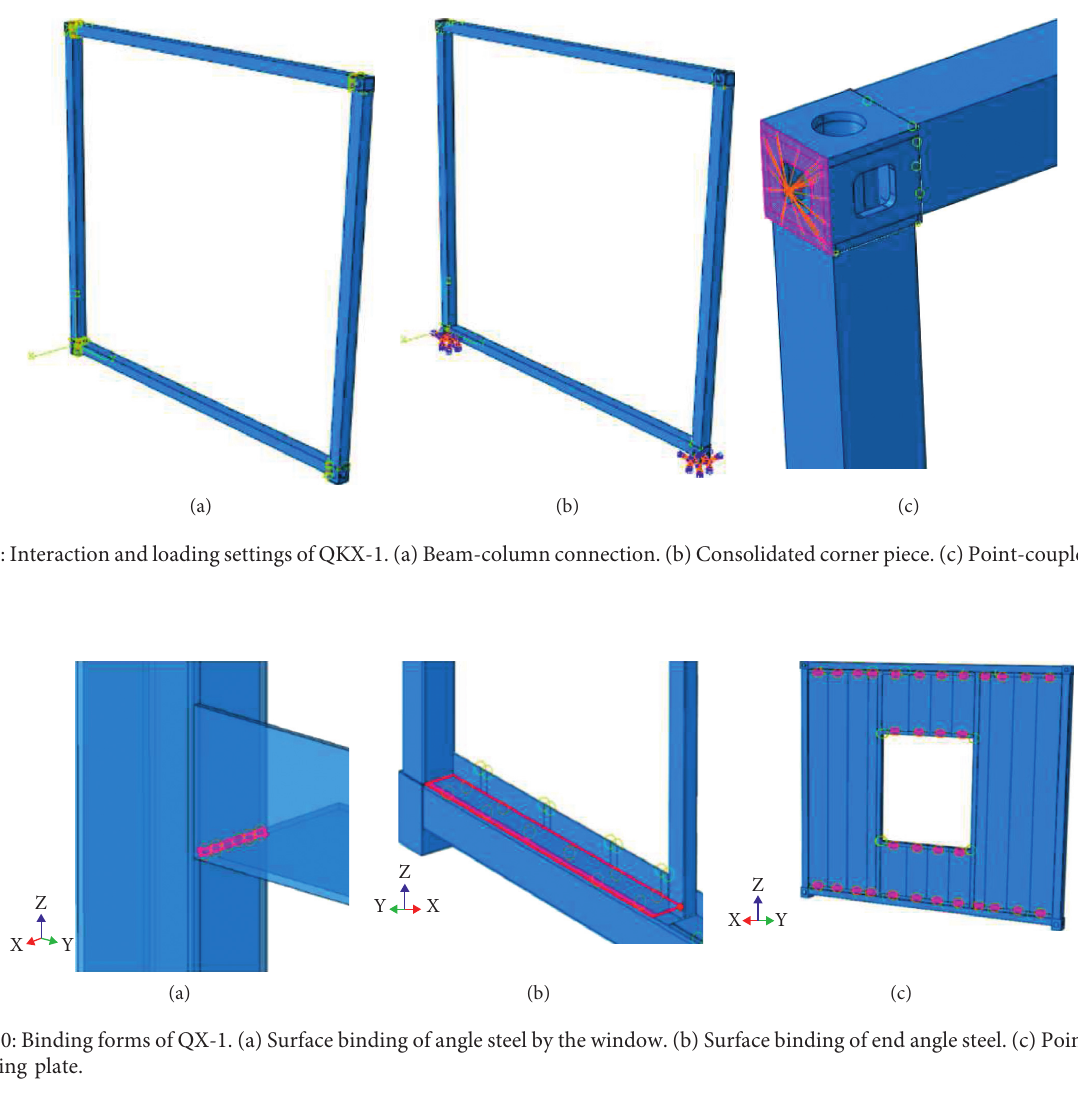
by finite element model with two-point binding between the end of the bent plate and the angle steel is closer to the experimental result.